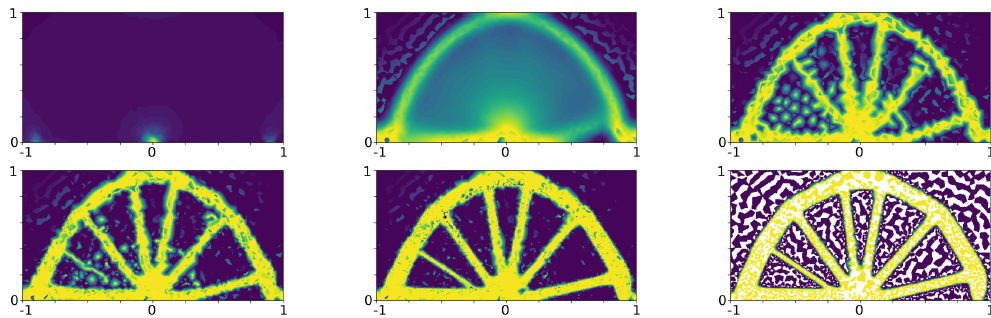
Figure A3. Iterations ϕ 1 , ϕ 100 , ϕ 200 , ϕ 300 , ϕ 400 , ϕ 490 from Algorithm A2. Algorithm A1: Deterministic optimisation algorithm from